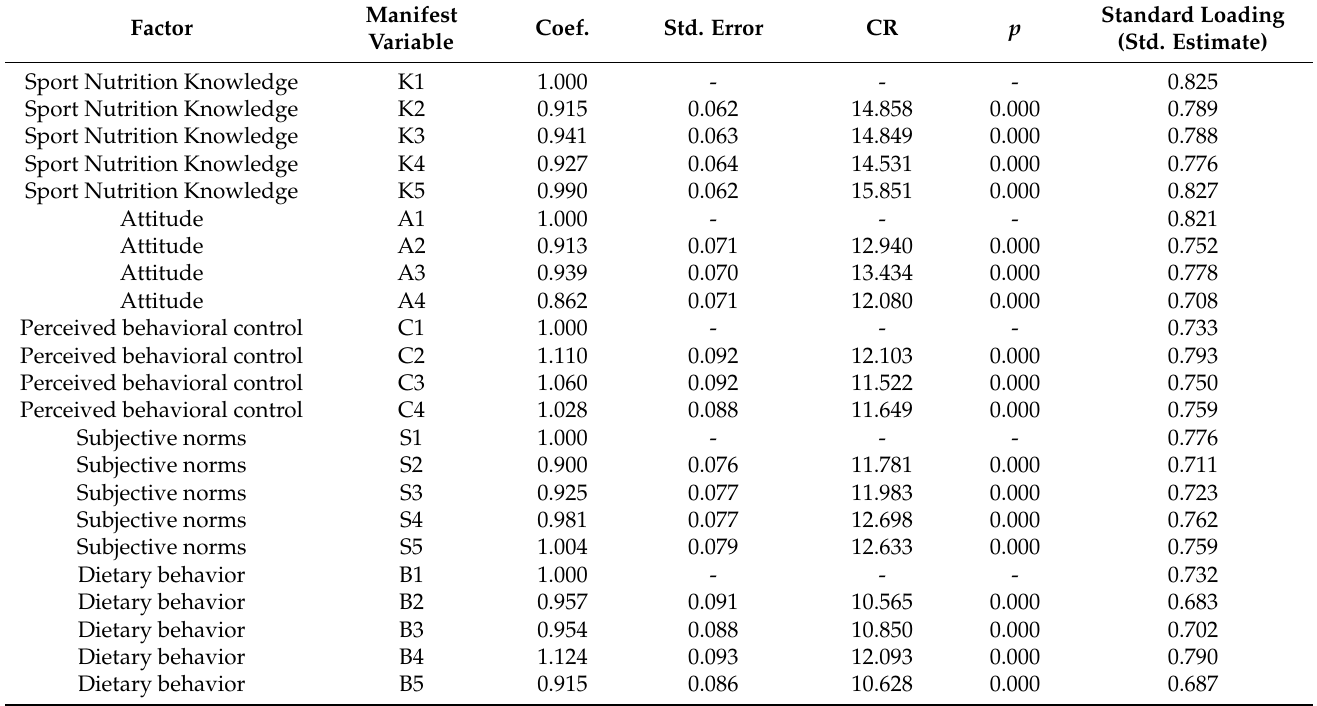
Table 2. Factor loading coefficients.